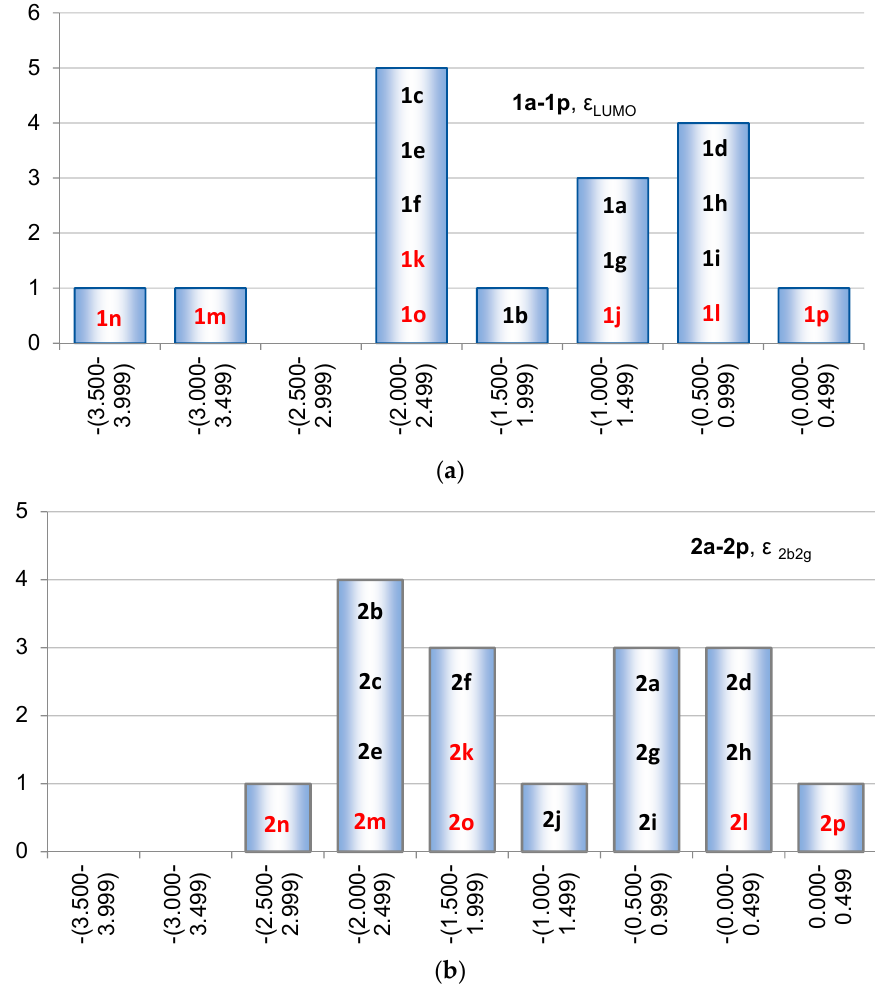
Figure 10. Distribution of ( a ) the ε LUMO for 1a – 1p and ( b ) the ε 2b2g for 2a – 2p ( ε LUMO for 2a ). Compound numbers of compounds substituted at the Si atoms in black and those substituted at the C atoms in red.